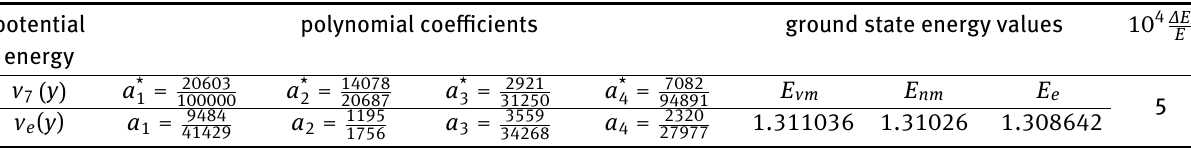
Table 7: Physical parameters for the potential energy v 7 ( y ) = y 2 + y 3 + y 4